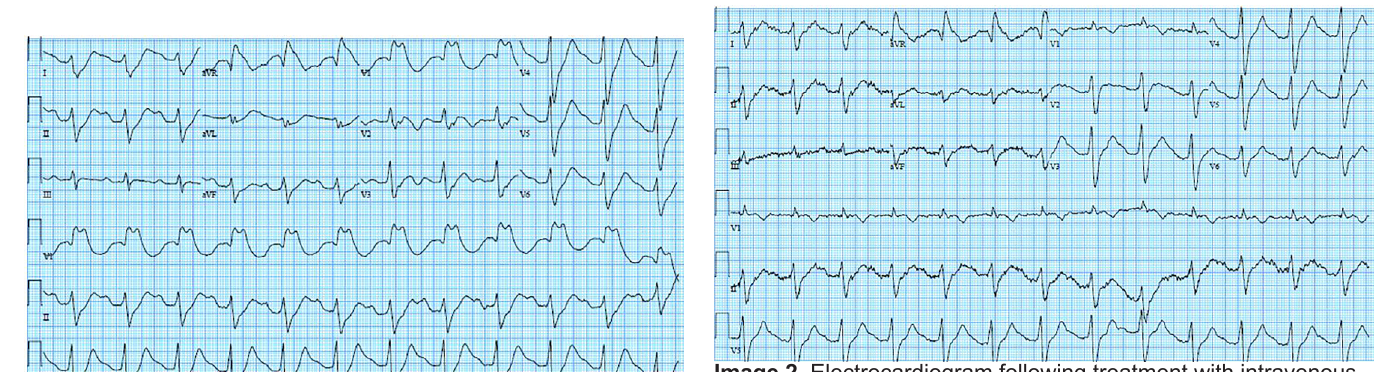
Image 2. Electrocardiogram following treatment with intravenous magnesium, calcium chloride, five boluses of sodium